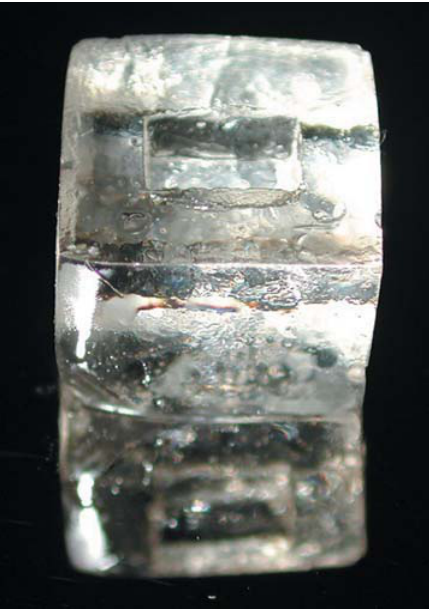
FIGURE 1- Box-shaped cavities simulating a class I preparation in transparent